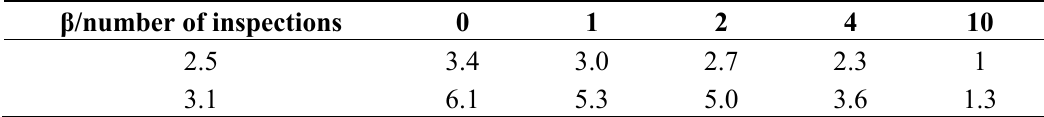
Table 19. Required FDF values for minimum cumulative reliability level. SN-curve: “With cathodic protection”. Close visual